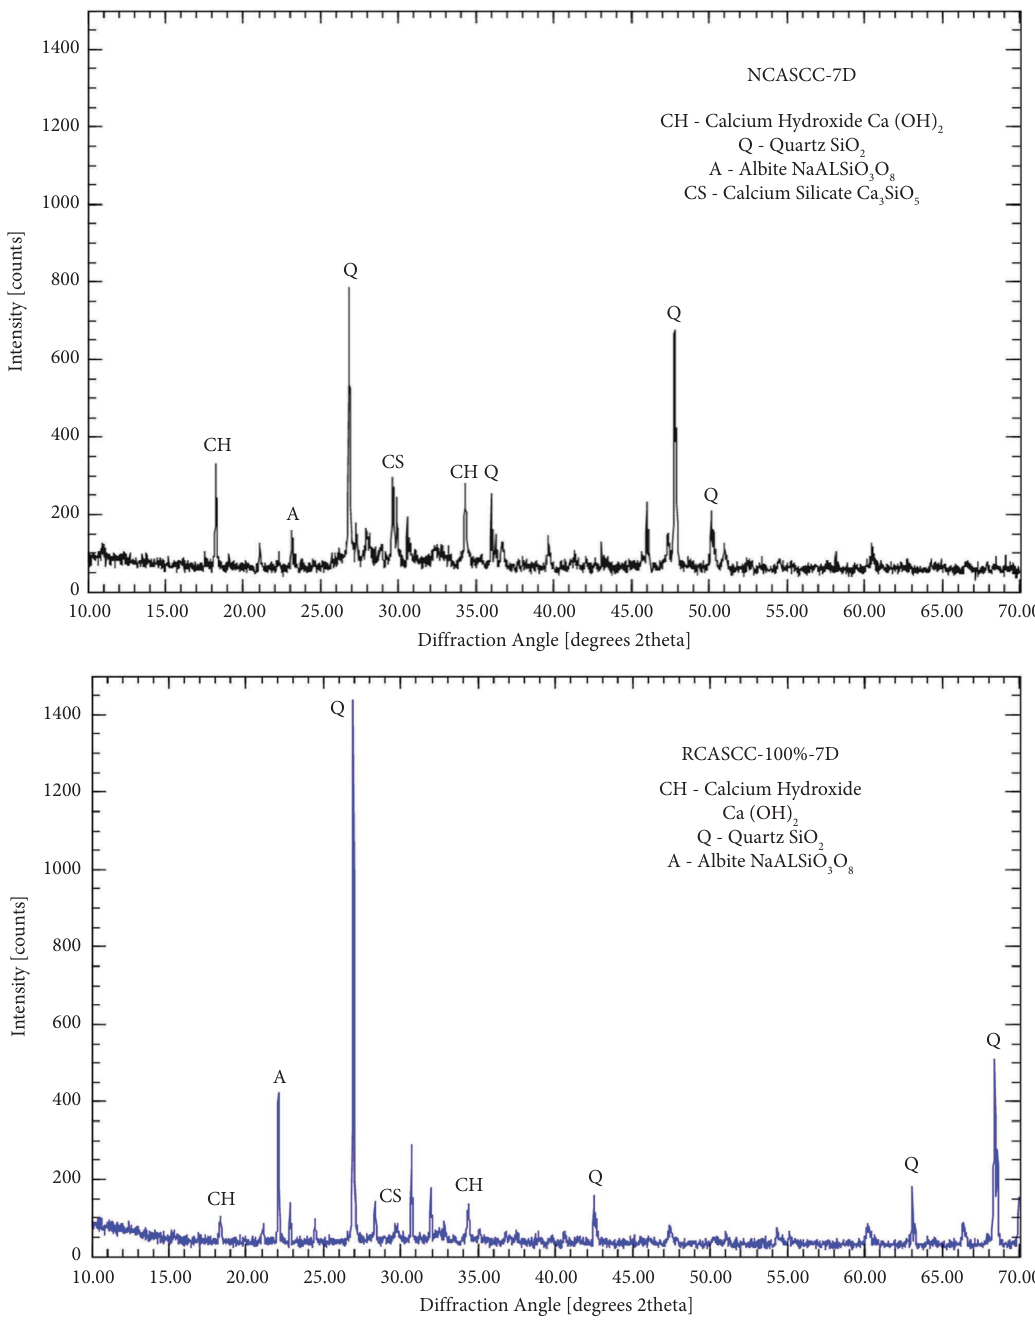
Figure 8: XRD analysis of NCASCC (a) and RCASCC-100